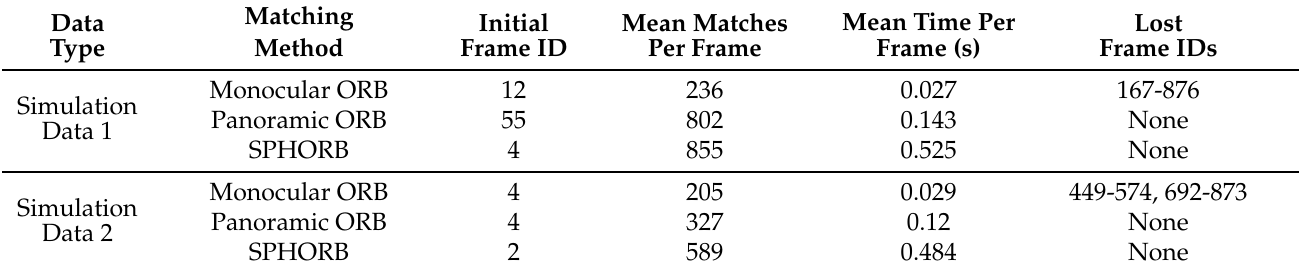
Table 4. Comprehensive evaluation of monocular ORB, panoramic ORB and